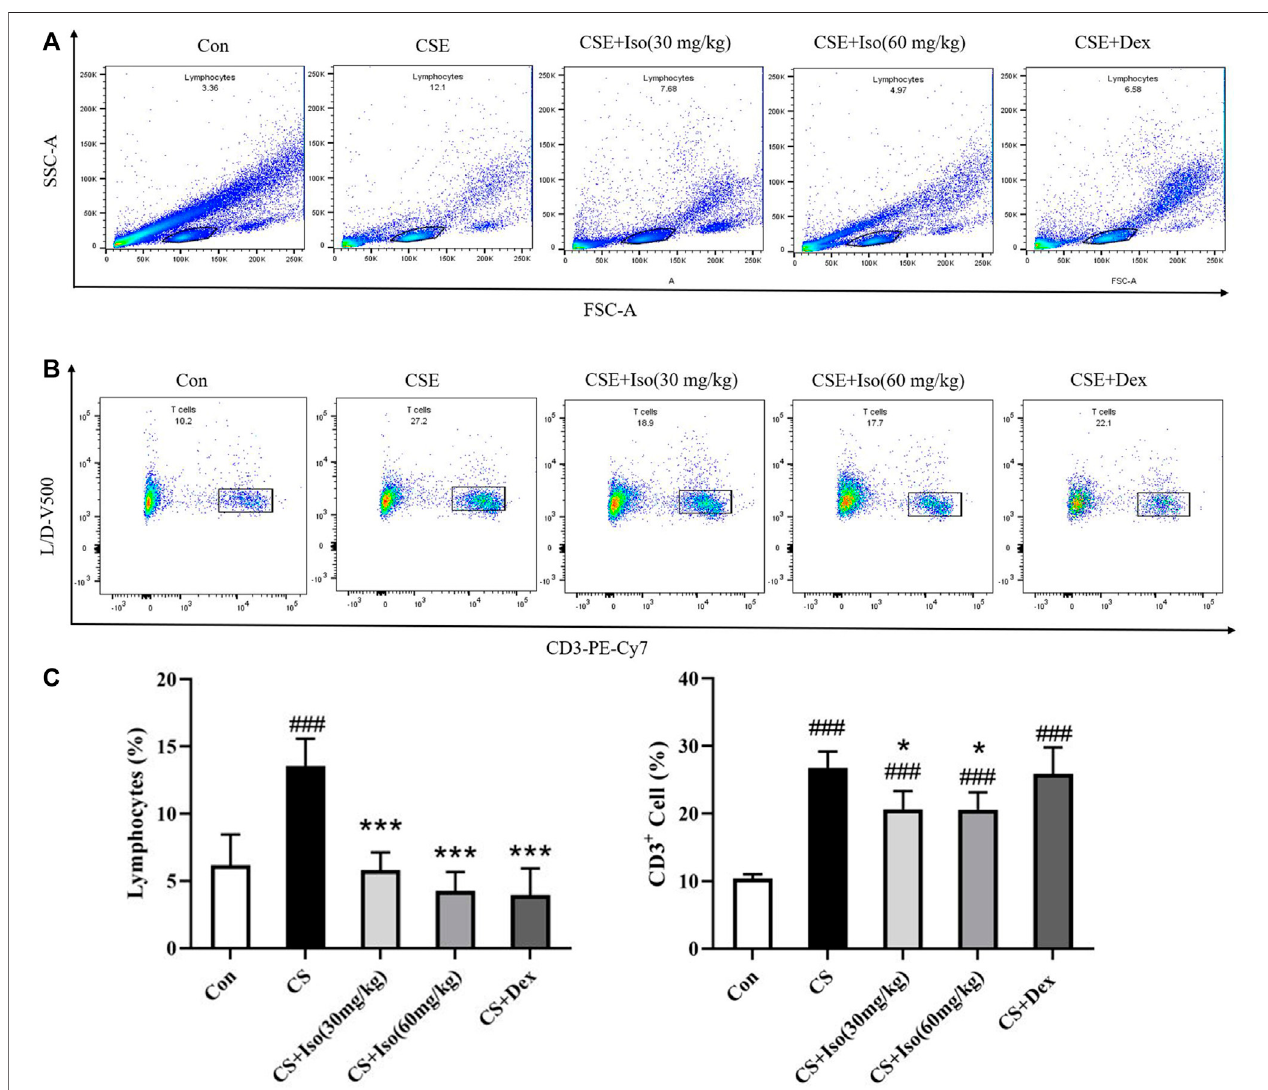
FIGURE8| Isoregulates Tlymphocytesinperipheralblood. Theexpression ofmarkersonTcellsinblood wasdetermined by fl owcytometry aftersurface staining with the anti-mouse speci fi c Abs conjugated with either PE-Cy7, PE, or APC. (A) Lymphocytes were identi fi ed based on their characteristic properties shown in by forward scatter area (FSC-A) and side scatter area (SSC-A). (B) CD3 + lymphocytes were identi fi ed based on their characteristic shown in PE-Cv7-A, and (C) the proportions of lymphocytes and CD3 + lymphocytes in whole blood were calculated separately ( n = 4 mice per group). Data was shown as mean (±SD) (C) . To test for group differencses one-way ANOVA (C) was applied. ### p < 0.001 vs. control group, * p < 0.05, *** p < 0.001 vs. CS group.